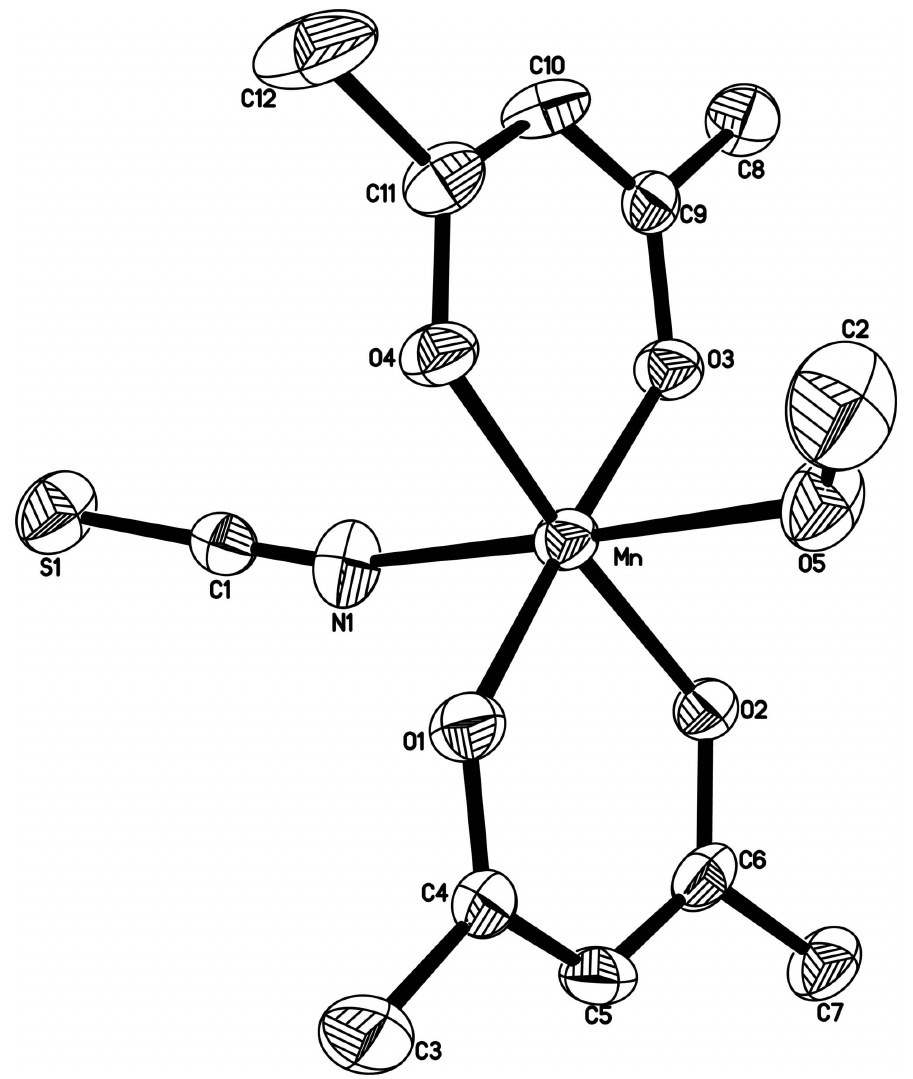
A view of the title complex with the atom-labelling scheme. Displacement ellipsoids are drawn at the 30% probability level. H atoms have been